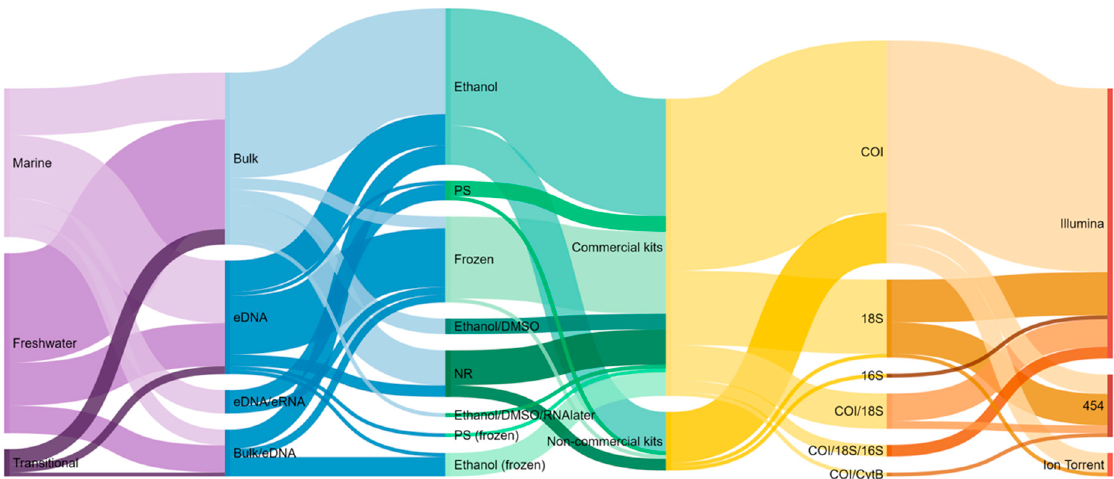
Figure 8. Diagram resuming the methods employed at each stage of the analytical chain of the metabarcoding workflow from the 90 publications analyzed in the current study. The thickness of the lines corresponds to the number of publications using a method. NR represents studies where the corresponding stage/method was not reported and PS represents preservation solution.